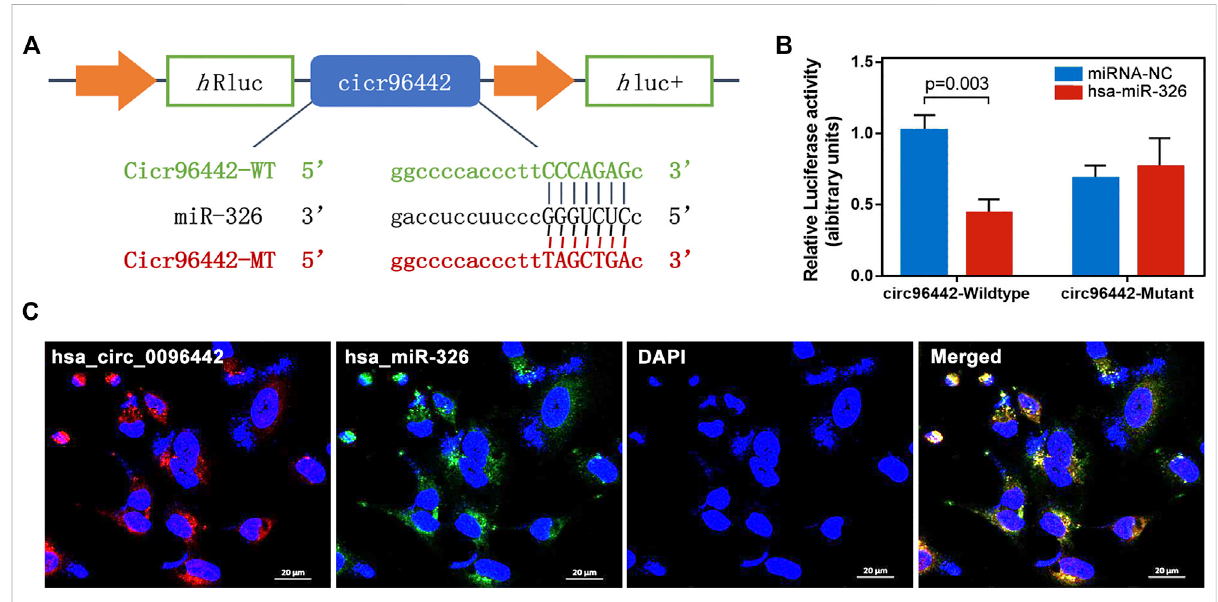
FIGURE 8 Circ_0096442 acted as a sponge of miR-326 in A549 cells. (A) Schematic representation of potential binding sites between circ_0096442 and miR-326. (B) The luciferase activity of the WT psicheck2-circ_0096442 or Mut psicheck2-circ_0096442 after transfection with miR-326 mimics in A549 cells. (C) FISH showed the subcellular co-localization between circ_0096442 (red) and miR-326 (green). DAPI (blue) was used to stain the